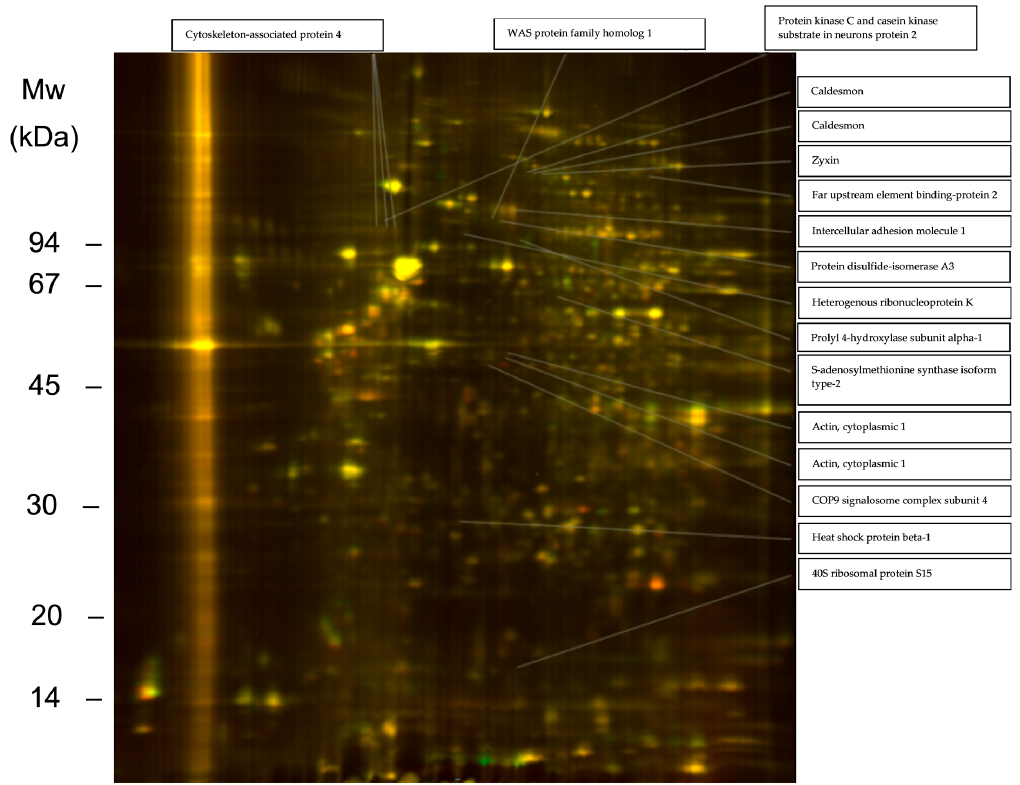
Figure 3. 2D-DIGE gel of proteins from TNF α preinflamed, CXCL8 incubated cells treated with heparinase and chondroitinase (Cy3 stained, red) versus untreated controls (Cy5 stained, green). Proteins present in both samples appear in various shades of yellow depending on their relative quantity.